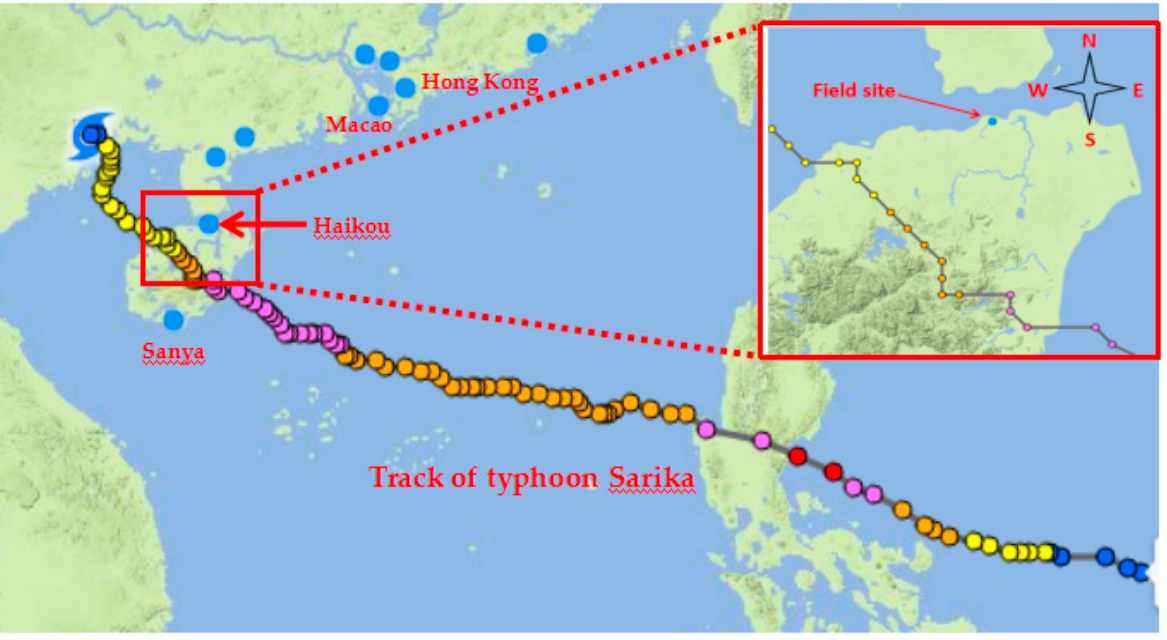
Figure 1. Track of typhoon Sarika and surrounding environment of field site. The 36.5 h wind-field data collected beginning at 23:00 on 17 October 2016 are used to record the wind speed and wind direction during Sarika. The measured maximum instantaneous wind speed is 34.84 m/s. Before Typhoon Sarika landing, the wind direction varies greatly and shows unstable, and during the passage of Typhoon Sarika landing, wind direction changes by approximately 180°, resulting the wind direction changes from approximately northerly to southerly. During the strongest landing passage of Typhoon Sarika, the wind direction is varied within 70~110°. Figure 2 shows the measured instantaneous wind speed and wind direction during Typhoon Sarika, the peak of 10-min mean wind speed is about 20.02 m/s and the 10-min mean wind direction is within 0°– 180°.